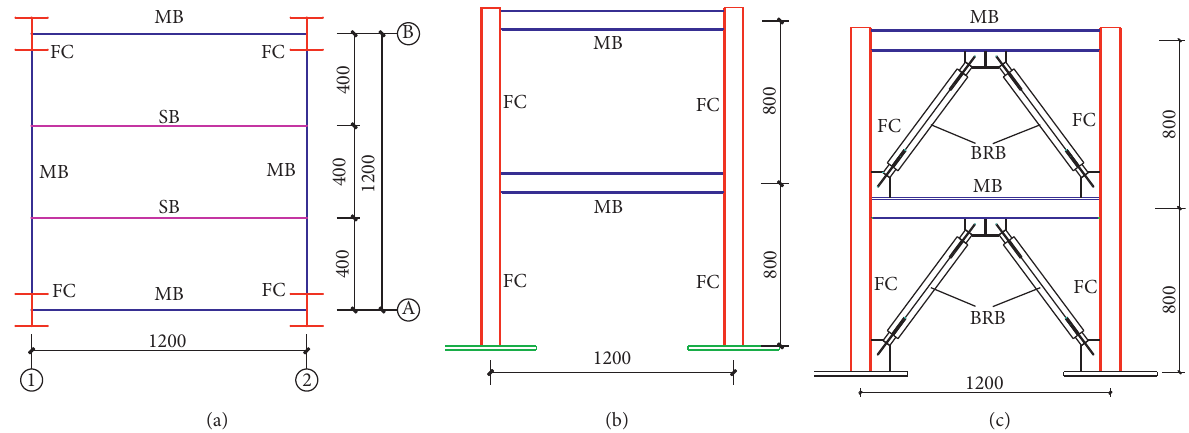
Figure 1: Plane and elevation layouts of the specimen (mm). (a) Plane layout of both models. (b) Elevation of the pure frame. (c) Elevation of the BRB frame.